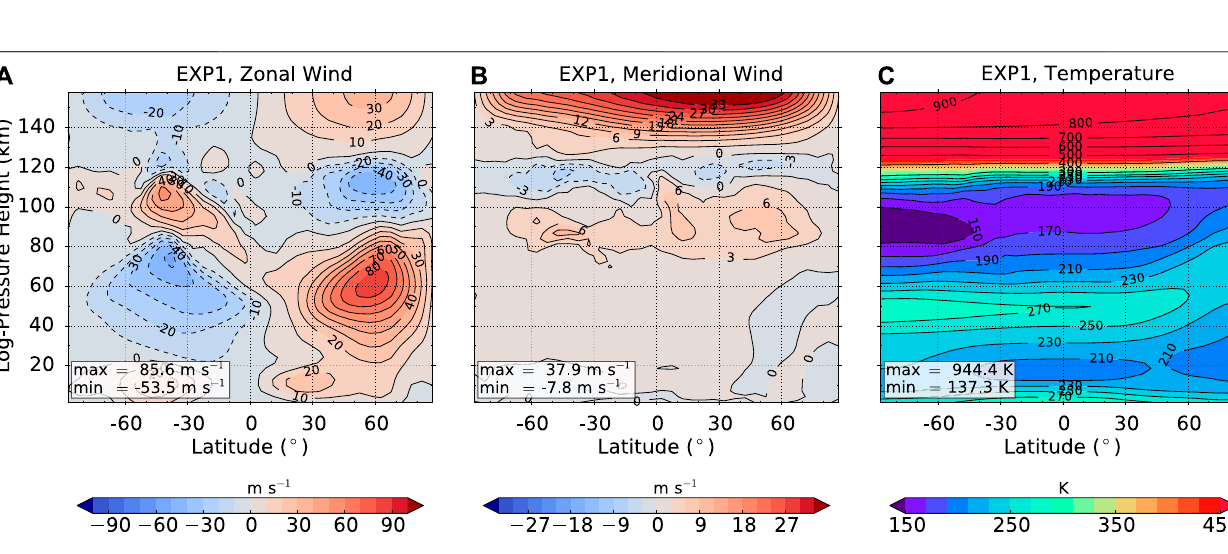
Frontiers in Astronomy and Space Sciences |